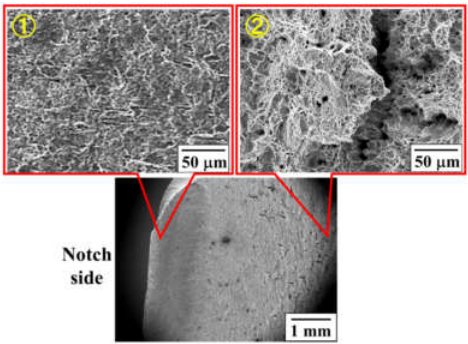
Figure 2. Scanning electron microscope (SEM) images for the Cr–Mo steel (SCM435) (MFC) Charpy impact test.